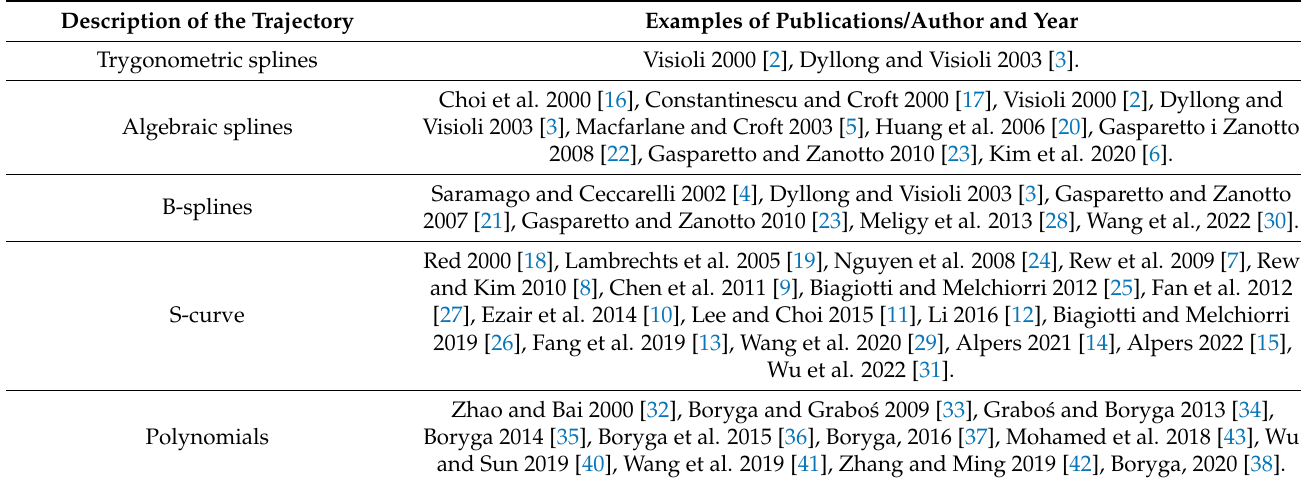
Table 1. Collation of publications using typical parametrization of the